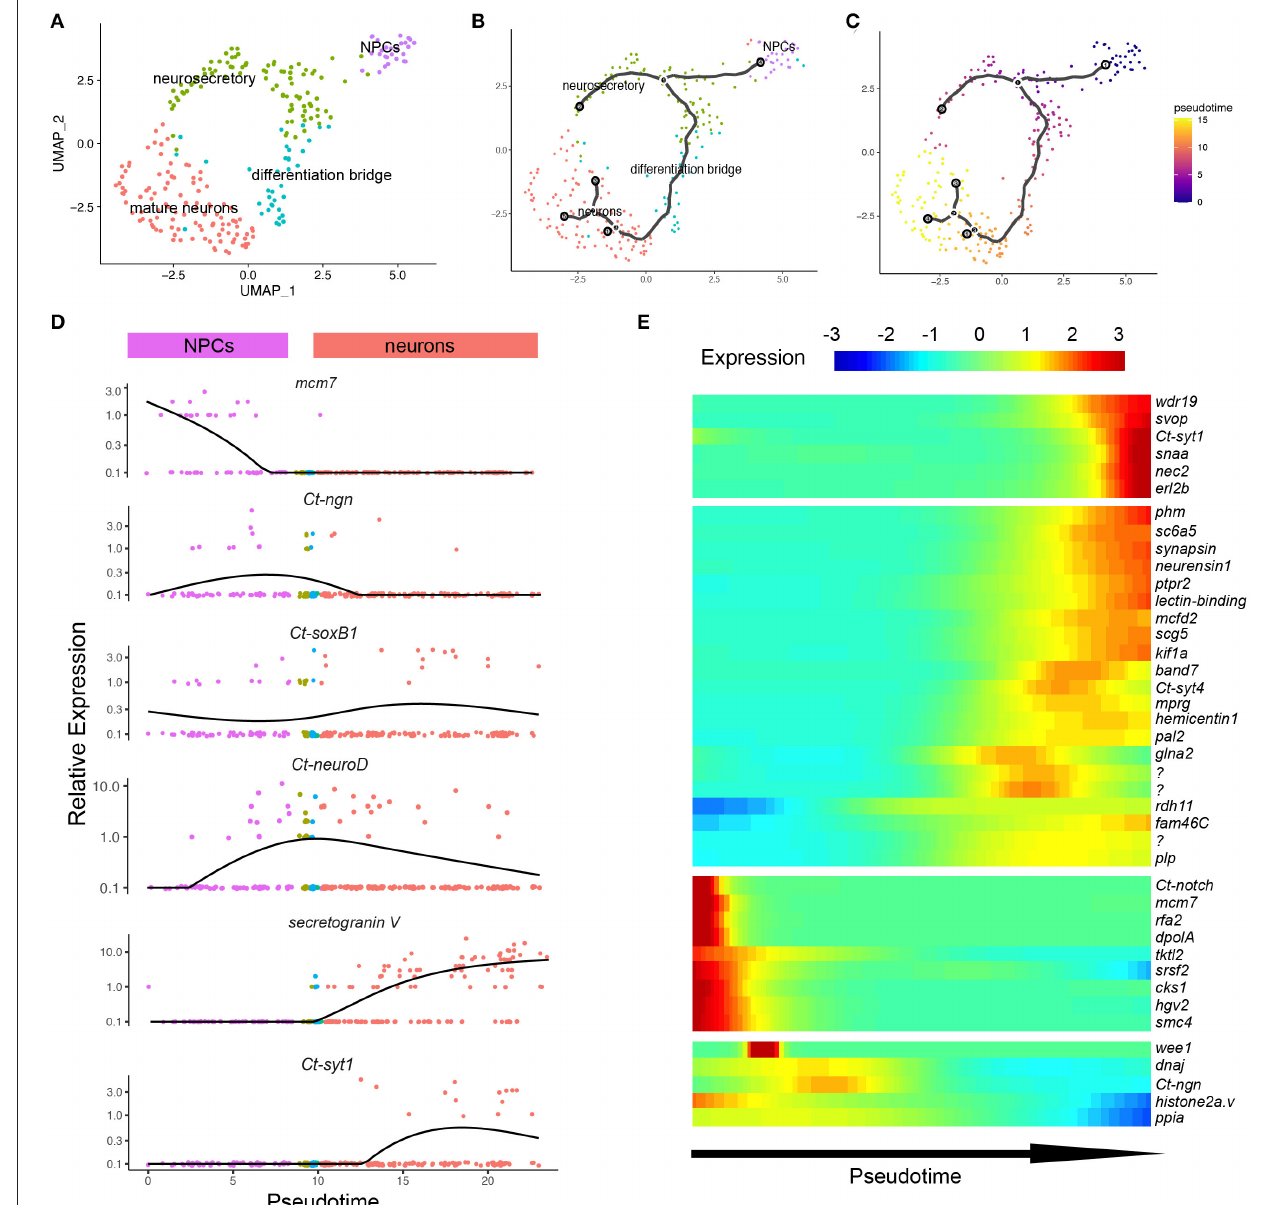
FIGURE 6 | Lineage relationships between neural cell types and pseudotime analysis. (A) UMAP representation of single-cells from the neural + neurosecretory cell-cluster generated in the stage 5 unsupervised clustering. (B) Trajectory analysis using Monocle3 predicts a neural differentiation trajectory that begins with NPCs and ends with the mature neuronal and neuroendocrine cell cluster. The root of the trajectory lies within the NPC cell-cluster. (C) Monocle3 pseudo-temporal ordering of neural cells superimposed on the Seurat UMAP plot. Cells are colored based on their progression along pseudo-temporal space from pseudotime 0 in violet to the end of differentiation in yellow. (D) Monocle analysis predicts progressive expression dynamics of mcm7 homolog, Ct-ngn , Ct-soxB1 , Ct-neuroD , secretogranin-V , and Ct-syt1 . (E) Heatmaps showing most significant TFs and effector genes clustered by pseudotemporal expression pattern ( q < 0.01). Pseudo-temporal ordering is from left (NPCs) to right (differentiated neurons). Selected transcription factors are shown for each cellular state along the differentiation trajectory.